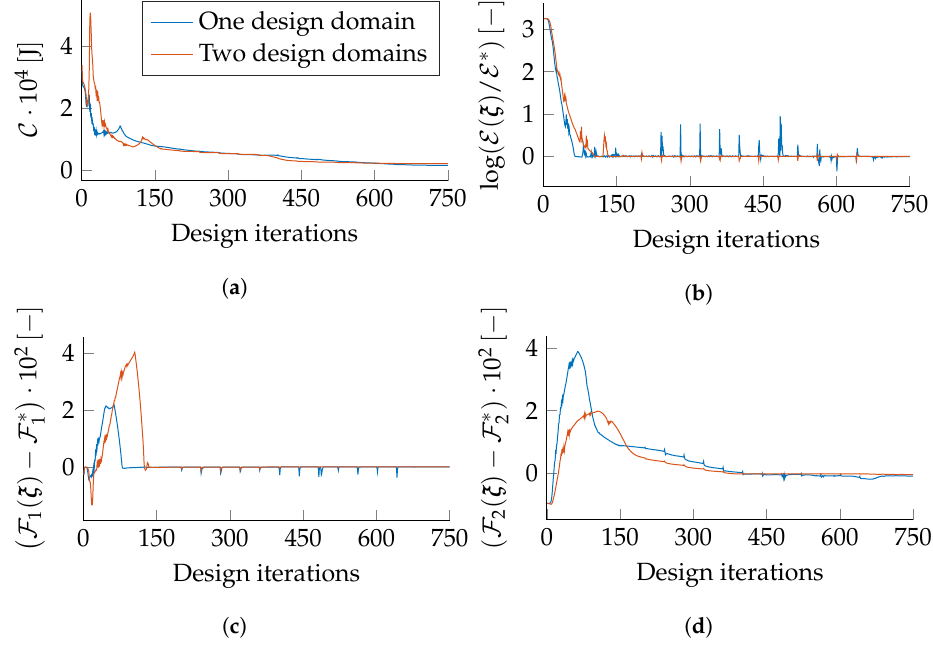
Figure 9. Optimization iteration histories of the two density approach examples. ( a ) Compliance. ( b ) Morphing displacement error constraint. ( c ) Volume Constraint 1. ( d ) Volume Constraint